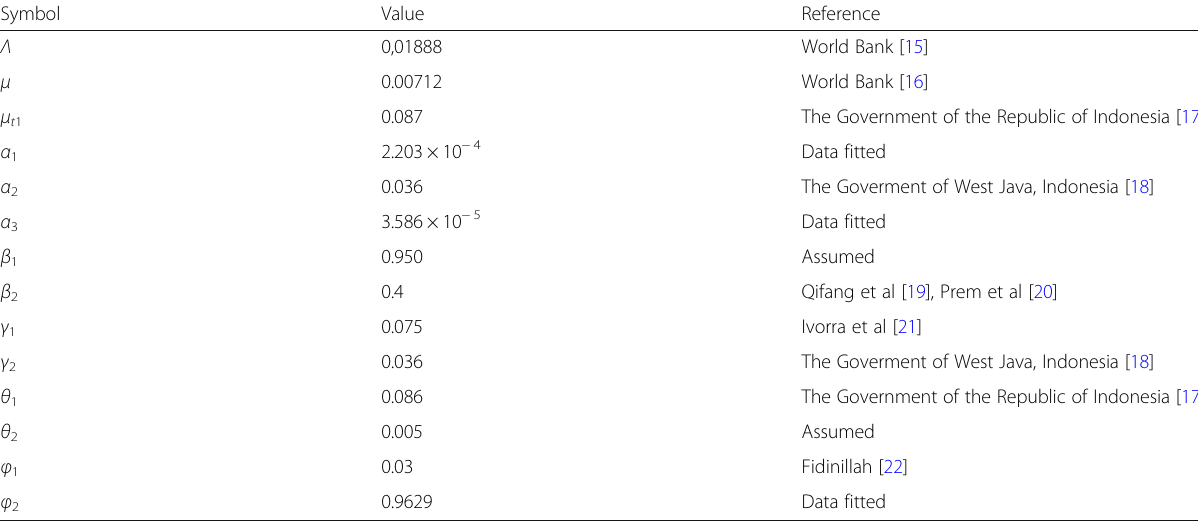
Table 2 Value of parameter for COVID-19 transmission in Indonesia Symbol Value Λ